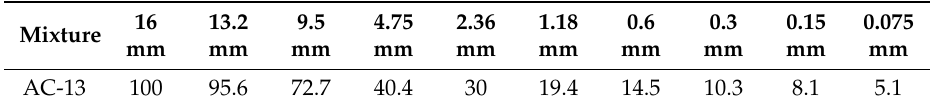
Table 2. Mixture gradation.